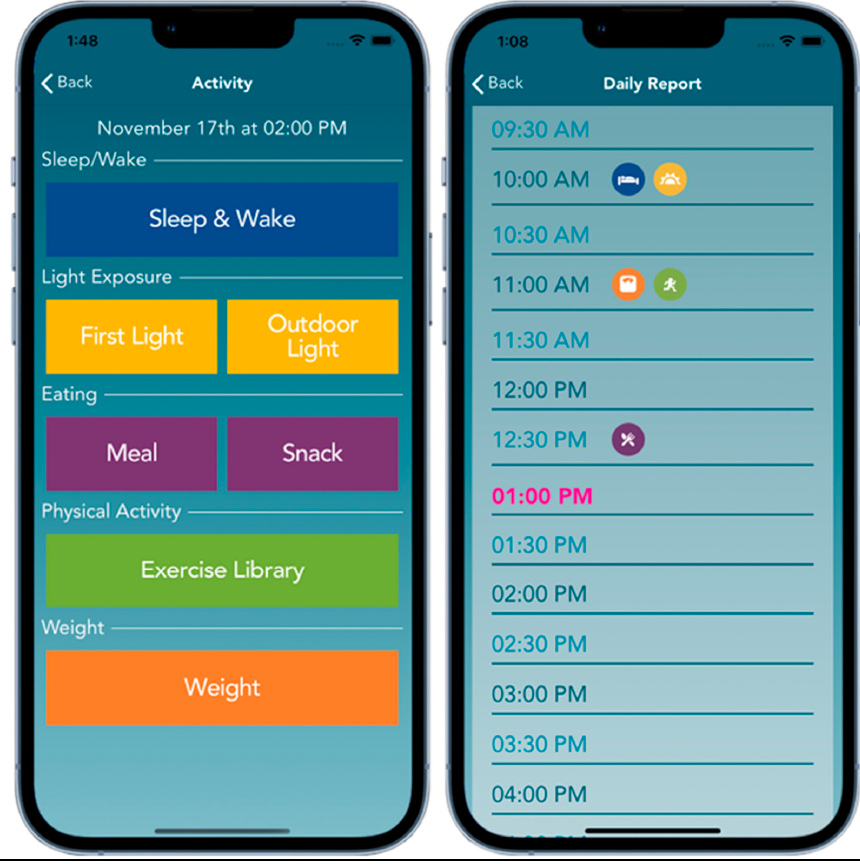
Figure 2. ClockWork digital monitoring prototype.